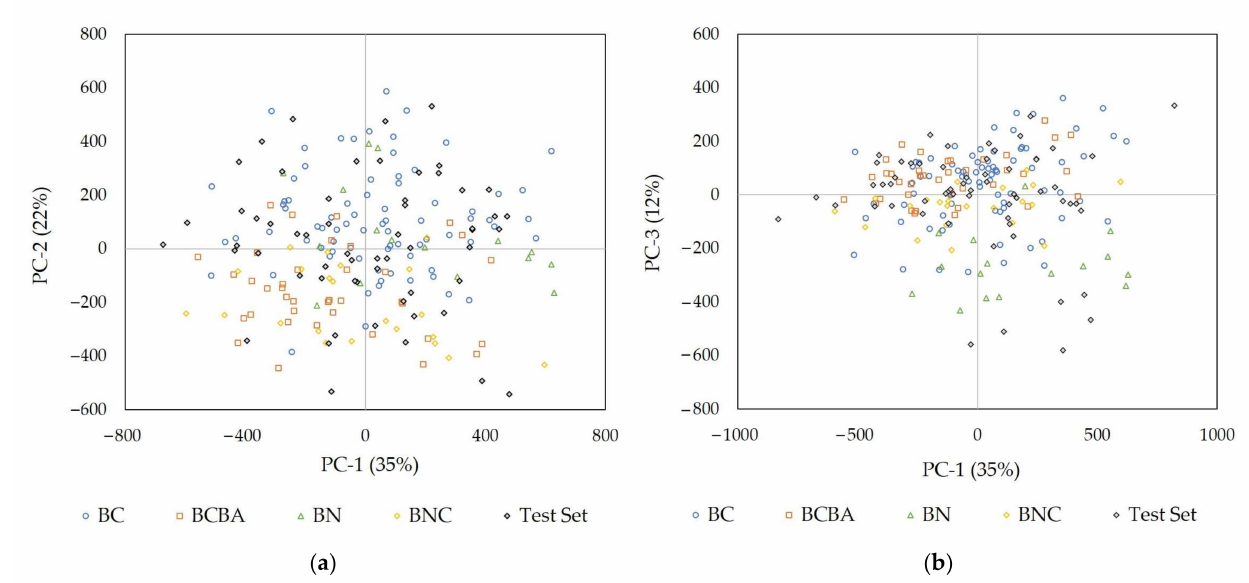
Figure 3. PCA score-plots: ( a ) PC-1 vs. PC-2; ( b ) PC-1 vs. PC-3. Explained variance of each component given in parentheses. It is observed that no clustering is evidenced, even for those samples of the same lithology [8]. In this context, a K-means method was used to group the samples for further PLSR prediction. Figure 4 shows the PCA score-plot with the three clusters obtained (C1, C2, and C3). Although samples from the same lithology were classified into different clusters, C1 mostly contains BC; BNC and BCBA were mainly grouped in C1 and C2, while most BN samples were grouped in C3.